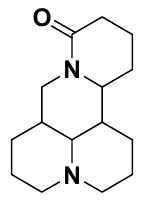
Figure 1. The structure of